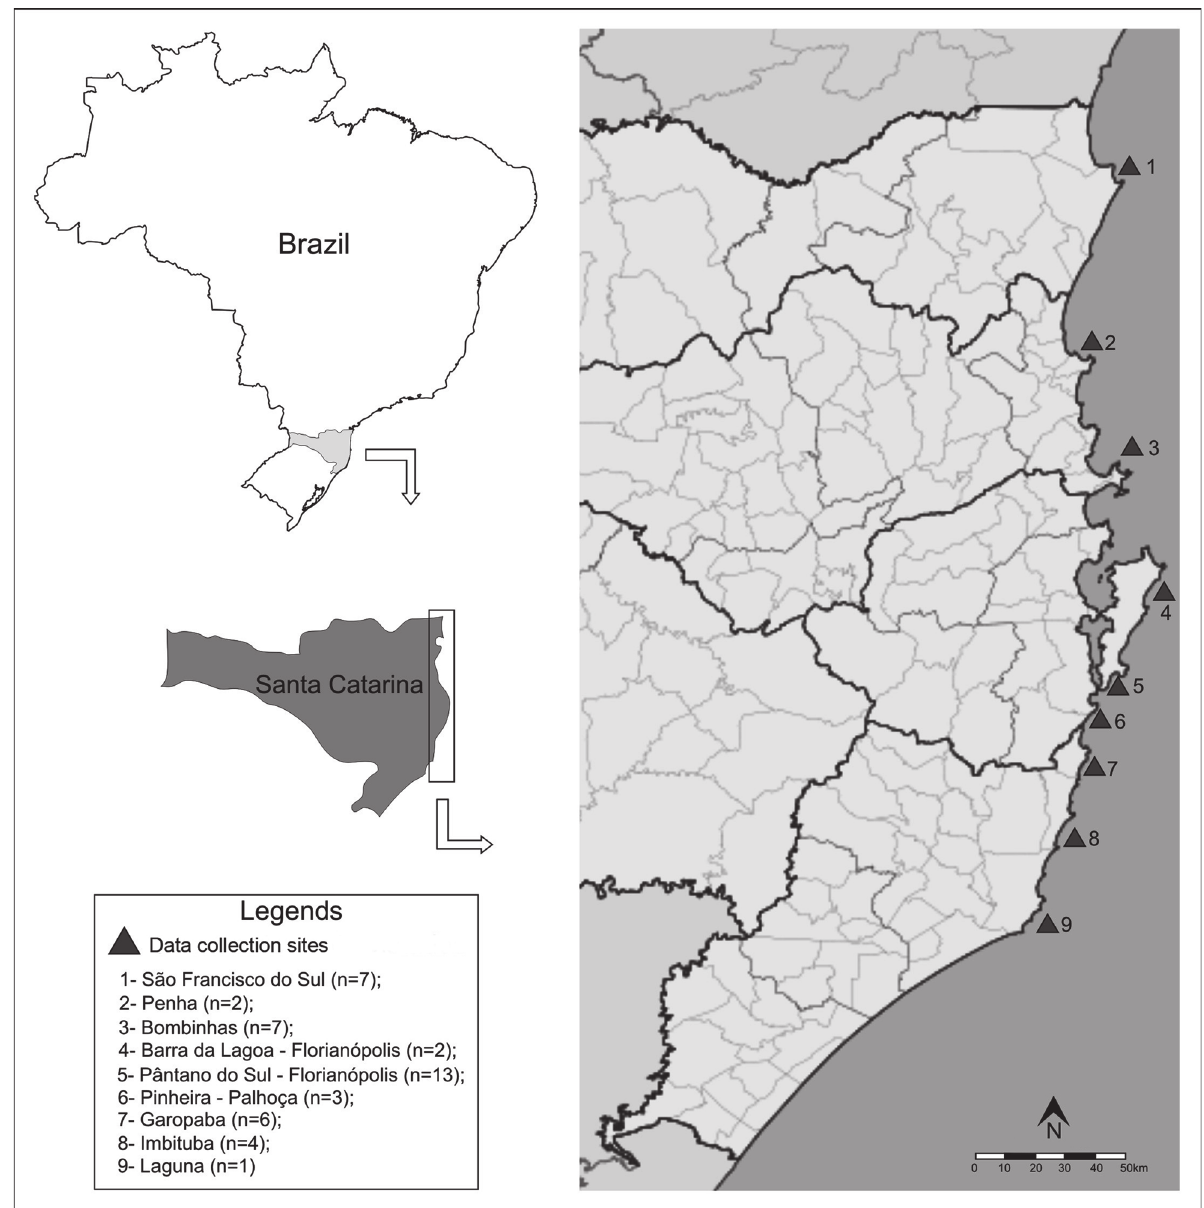
Fig. 1. Santa Catarina State coast, data collection sites (triangles) and the number of interviewed fishermen (in parenthesis; total N=45). Table 1. Questions of the semi-structured protocol with the main points of